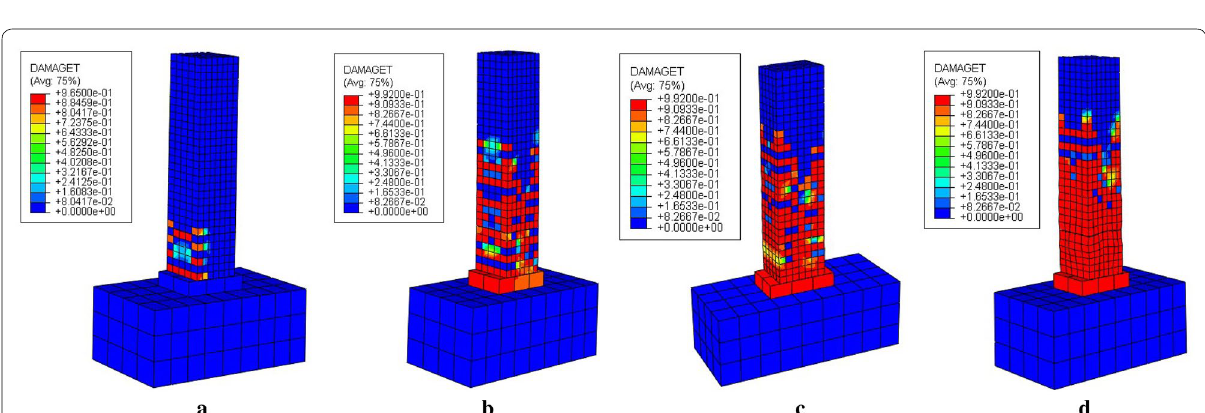
Fig. 15 Concrete damage development of ZP6: a cracking state; b yielding state; c ultimate state; d failure